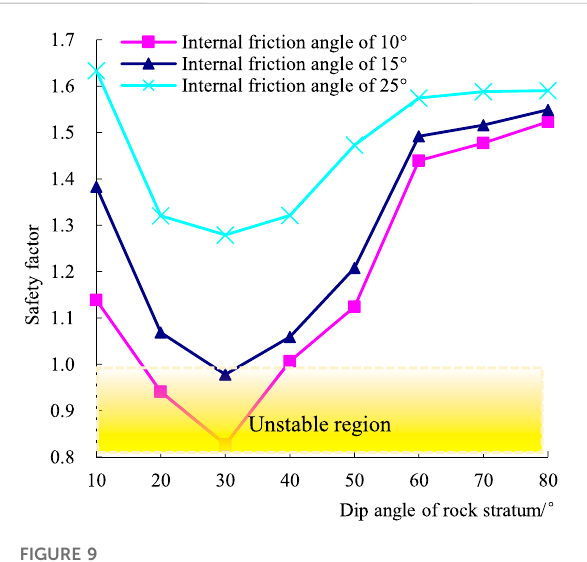
FIGURE 9 In fl uence of interlayer dip angle on safety factor at different internal friction angle of weak